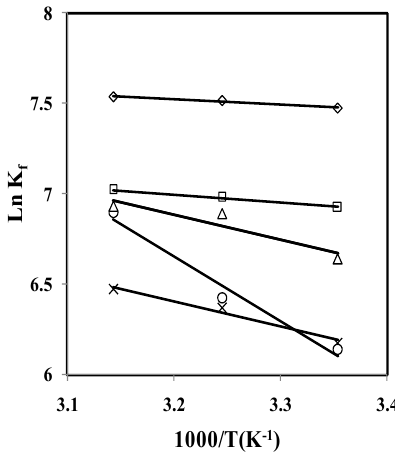
Figure 3. Van’t Hoff plots for ( p -isopropylcalix[6]arene·Cs) + complexes in DMSO-AN binary systems (mol% DMSO: ∆ = 100, ○ = 74.6, × = 52.5, □ = 32.9, ◊ = 15.5).